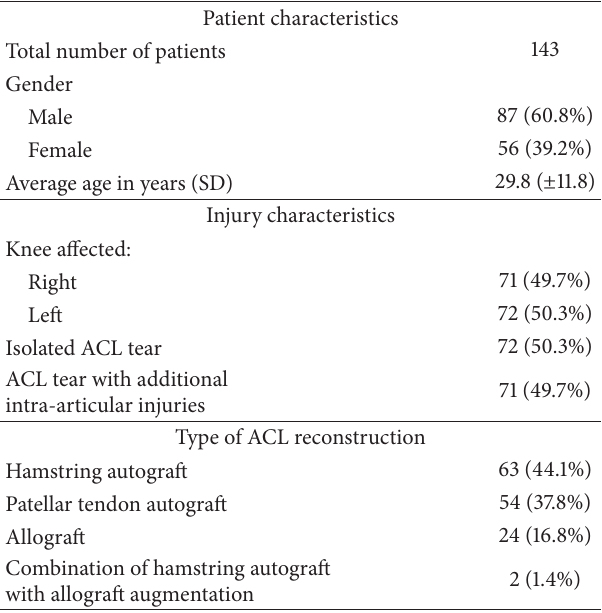
Table 1: Patient demographics, injury characteristics, and type of ACL reconstructions.